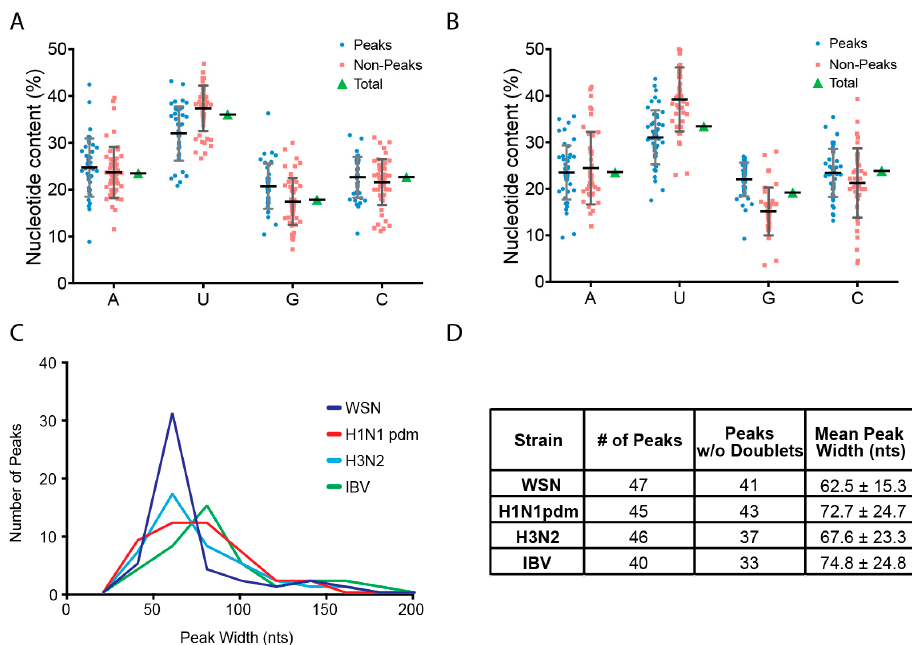
Figure 3. Characterization of NP-peaks. Regions of the vRNA segment that correspond to NP-peaks were identified using the peak calling algorithm MACS [24]. The percentage of each nucleotide was calculated for each peak and compared to non-peak regions as well as to the total genome sequence for A/Panama/07/99 H3N2 ( A ) and B/Texas/02/2013 ( B ). This analysis identified a statistically significant nucleotide bias for NP association in peaks, which are G-rich and U-depleted compared to non-peaks. ( C ) Histogram of the nucleotide foot-print of peaks from four strains: WSN, A/CA/07/09 H1N1pdm, A/Panama/07/99 H3N2, and B/Texas/02/2013. ( D ) Summary of the peak number and width described in C.